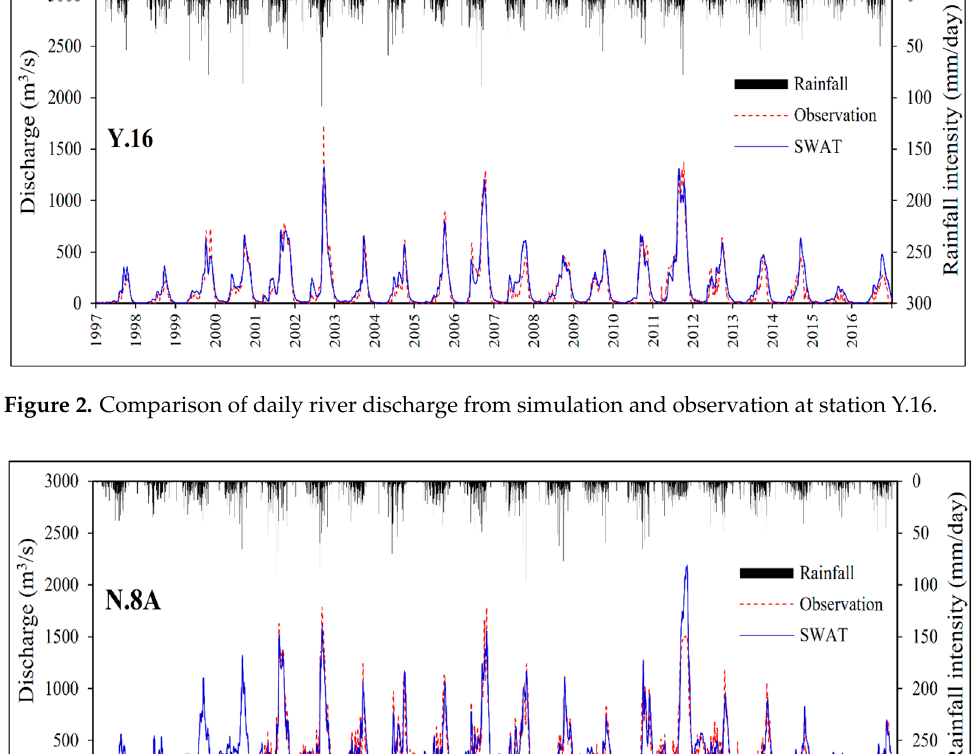
Table 2. Values of the Nash–Sutcliffe model Efficiency (NSE) and Root Mean Square Error (RMSE) for the calibration period (1997–2006).